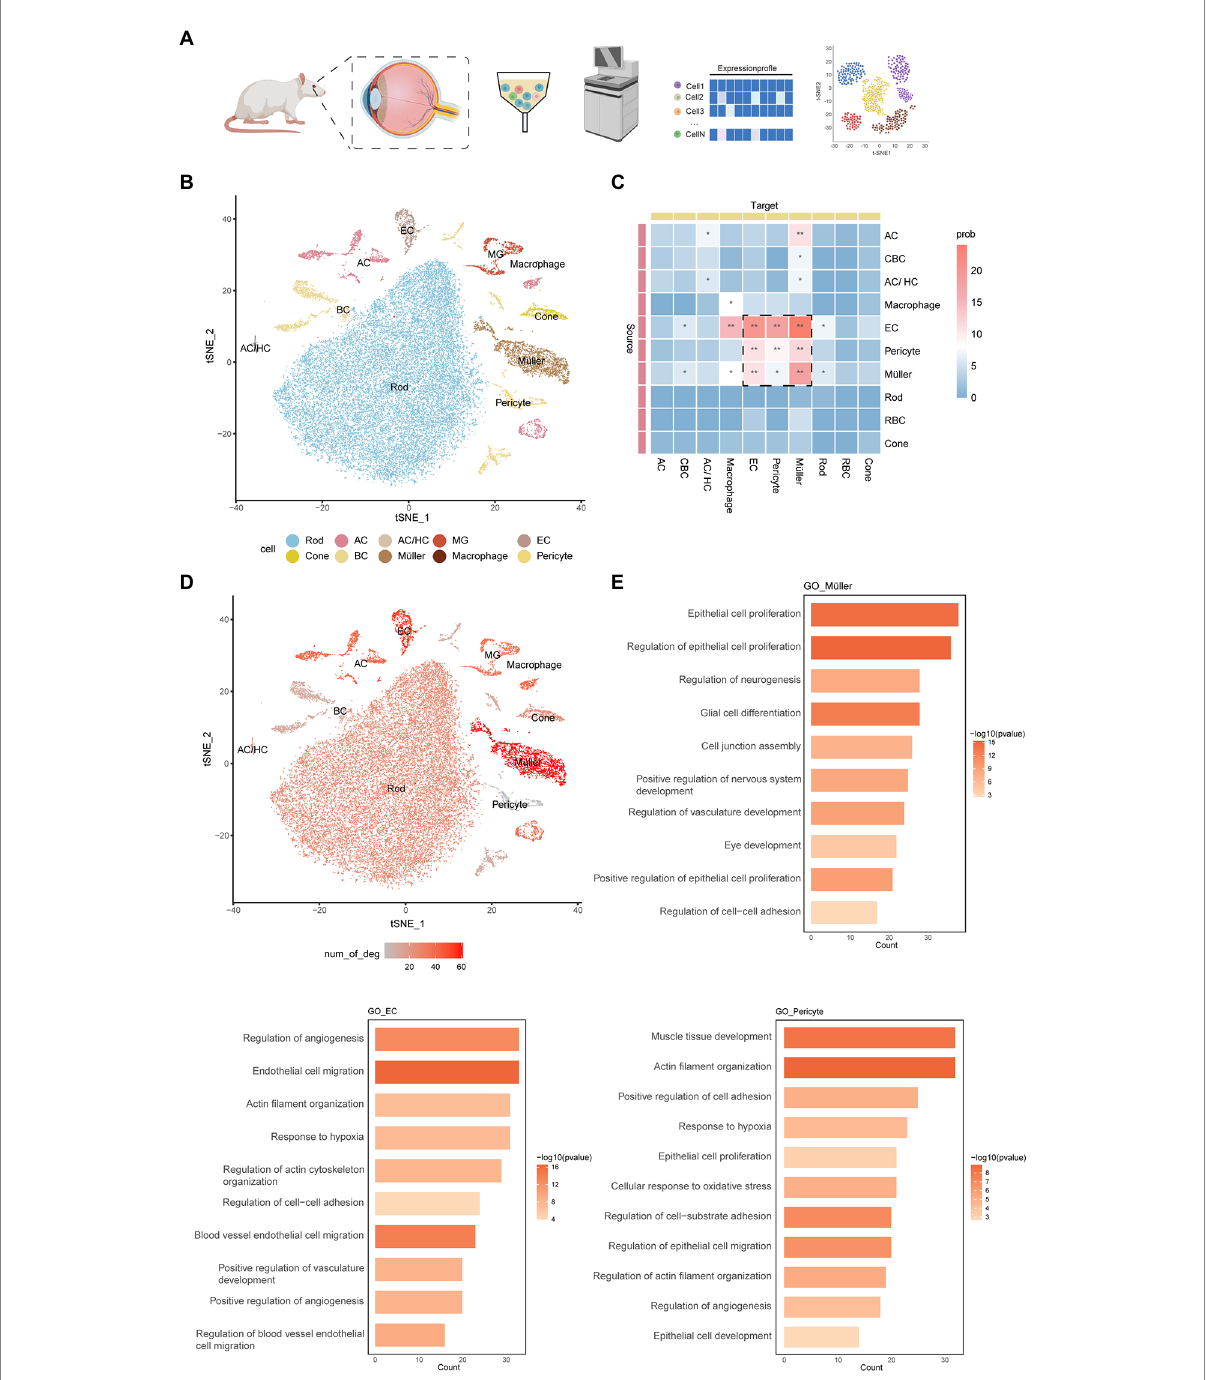
FIGURE 1 An atlas of cell types in the inner blood–retinal barrier. (A) Experimental design overview. Cell suspensions were collected from the experimental group (2 weeks, 4 weeks, 8 weeks) and the control group and subjected to 10x library preparation and sequencing, followed by downstream analyses. (B) tSNE plot showing different cell types. Cells assigned to the same cluster are similarly colored. AC, amacrine cell; HC, horizontal cell; EC, endothelial cell; MG, microglial cell; BC, bipolar cell. (C) The heatmap shows the communication relationships between cells. The source is the sender of the signal, the target is the receiver, and more asterisks indicate stronger communication. Strong communication is shown in red, and weak communication is shown in blue. Prob represents the strength of intercellular communication. (D) The feature plot shows the number of DEGs in different cells under DR and normal conditions. The three cells with the largest numbers were pericytes, Müller cells, and endothelial cells. (E) The histogram shows the GO enrichment results of pericytes, Müller cells, and endothelial cells, with length representing count and color representing -log10 ( p